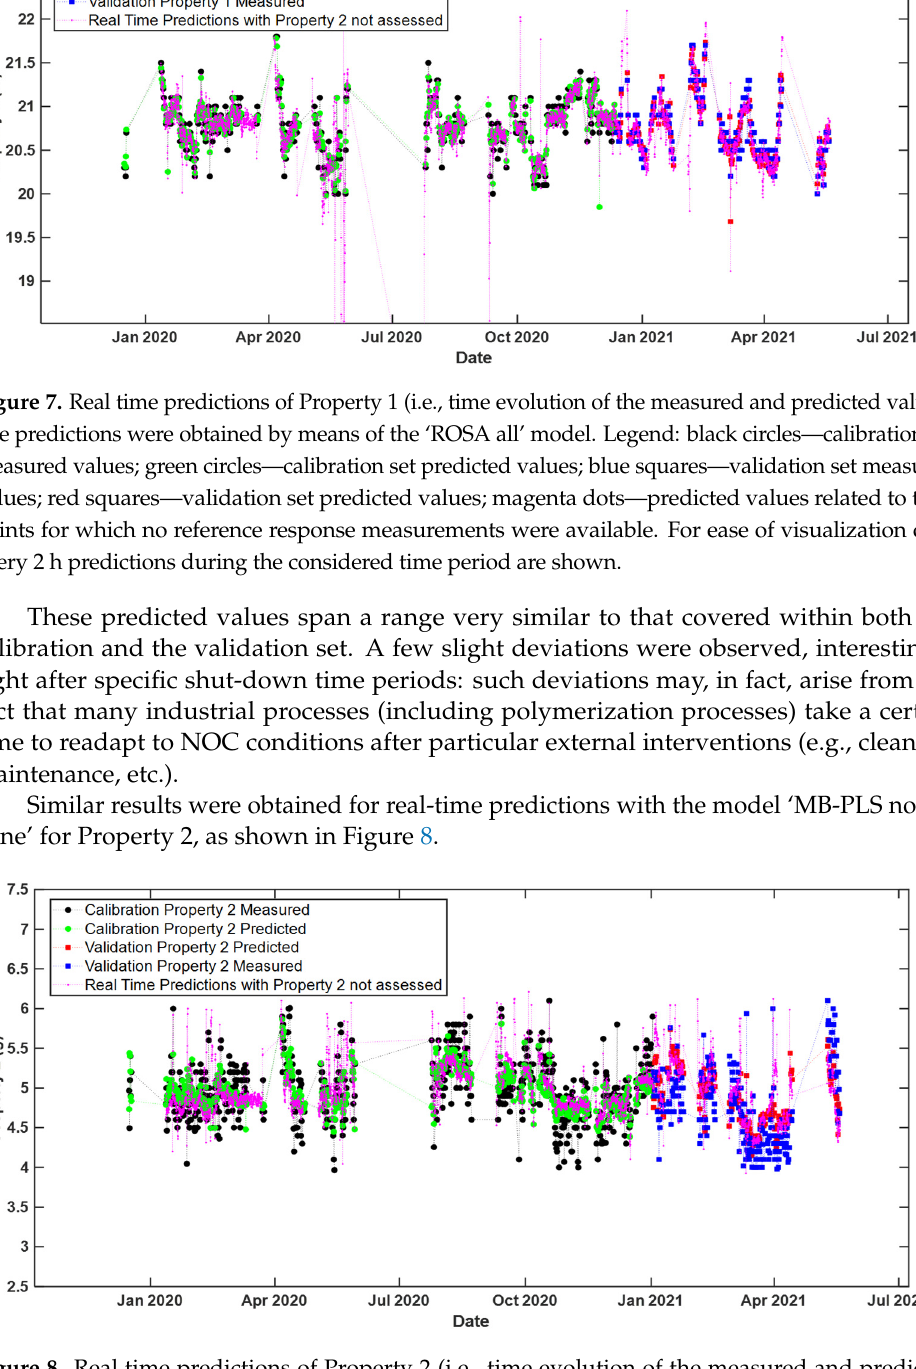
Figure 8. Real time predictions of Property 2 (i.e., time evolution of the measured and predicted values). The predictions were obtained by means of the ‘MB PLS no cut zone’ model. Legend: black circles—calibration set measured values; green circles—calibration set predicted values; blue squares—validation set measured values; red squares—validation set predicted values; magenta dots—predicted values related to time points for which no reference response measurements were available. For ease of visualization only every 2 h predictions during the considered time period are shown.